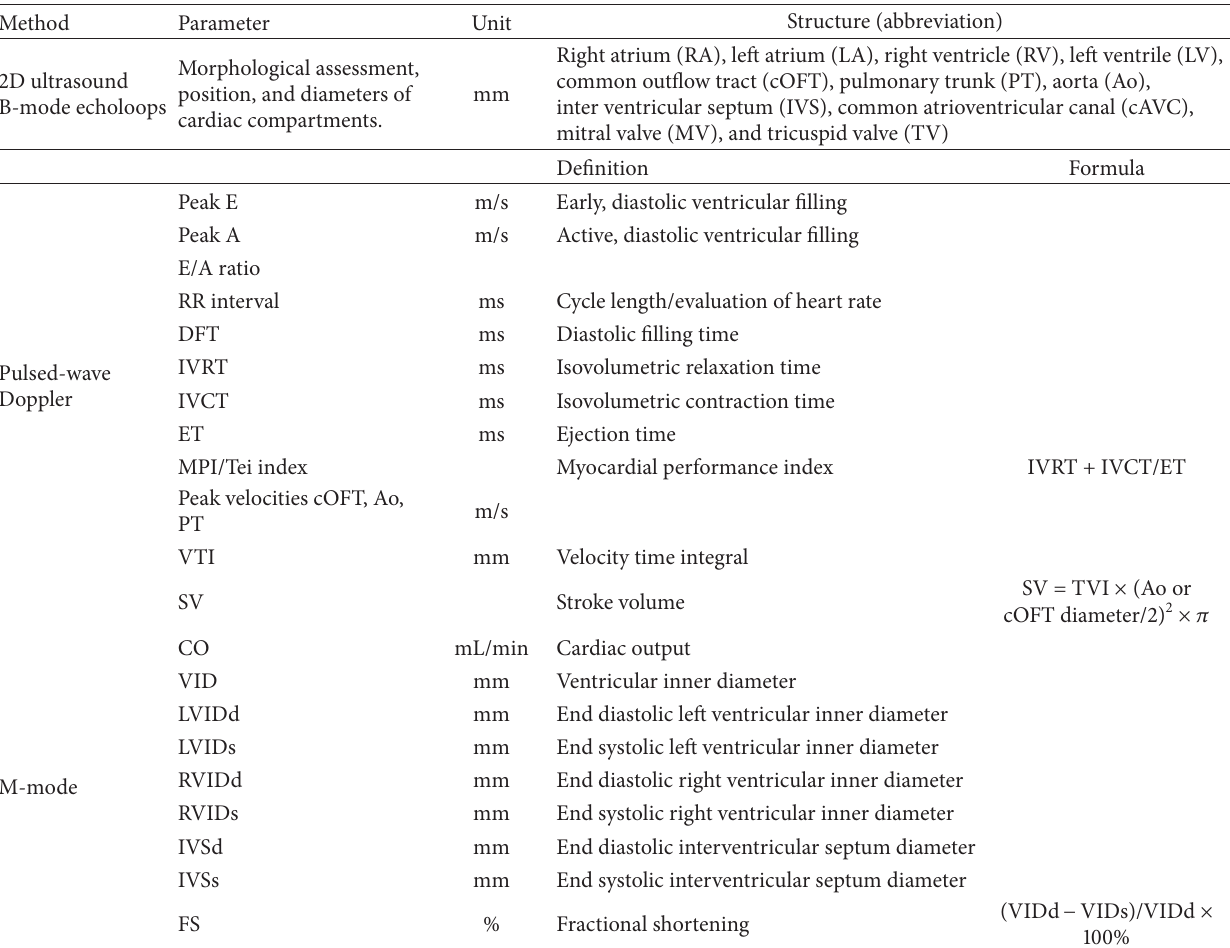
Table 2: Summary of the assessment of embryonic and fetal